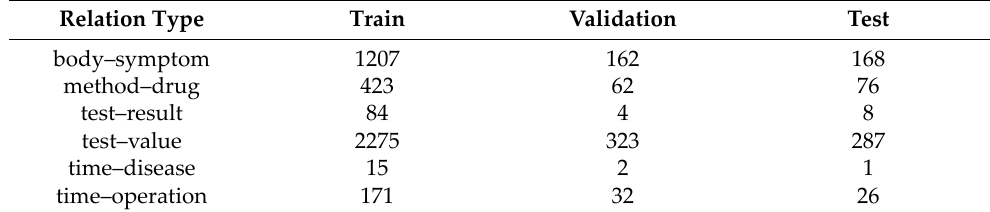
Table 3. Statistics on the number of relations in the